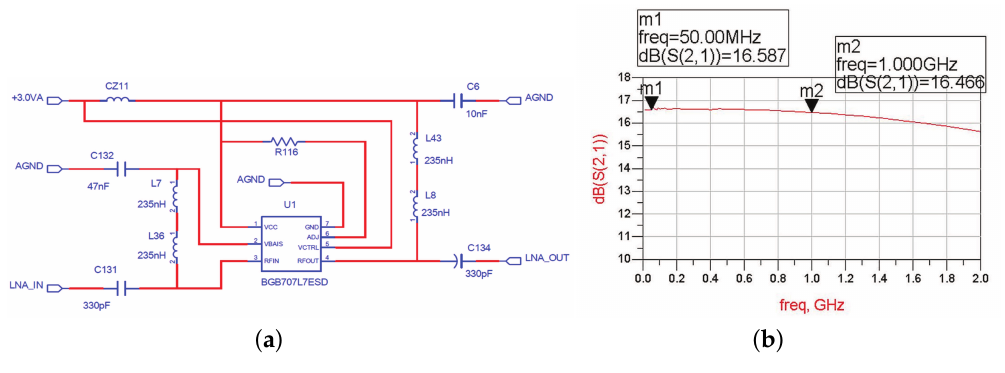
Figure 6. The circuit diagram ( a ) and frequency characteristic ( b ) of low noise amplifier